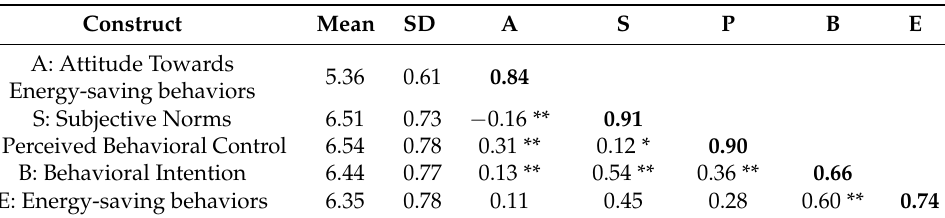
Table 3. Results of correlation